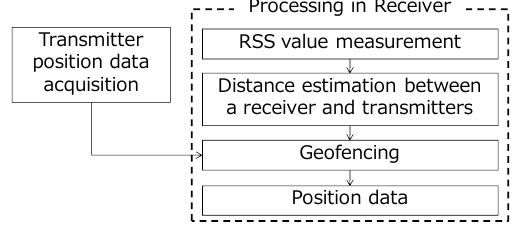
Figure 3. Nearest neighbor-based positioning